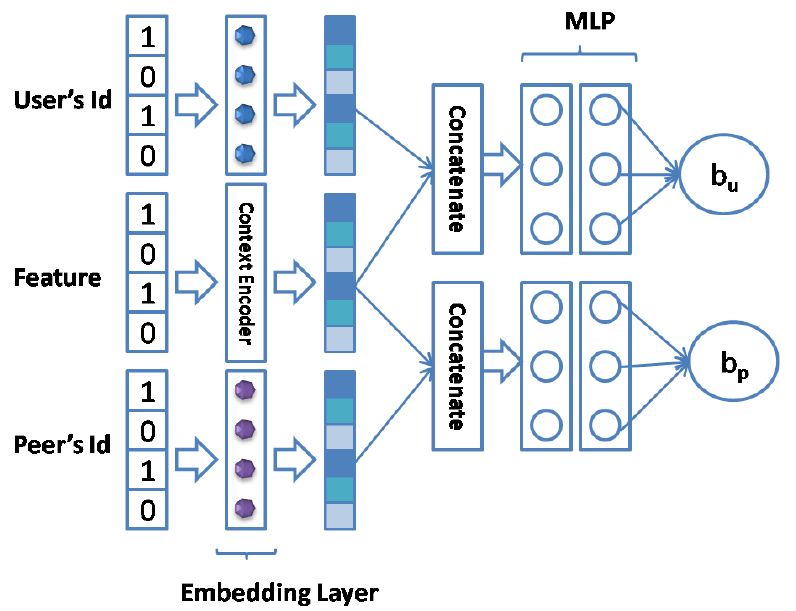
Figure 5. The Architecture of Bias Interaction